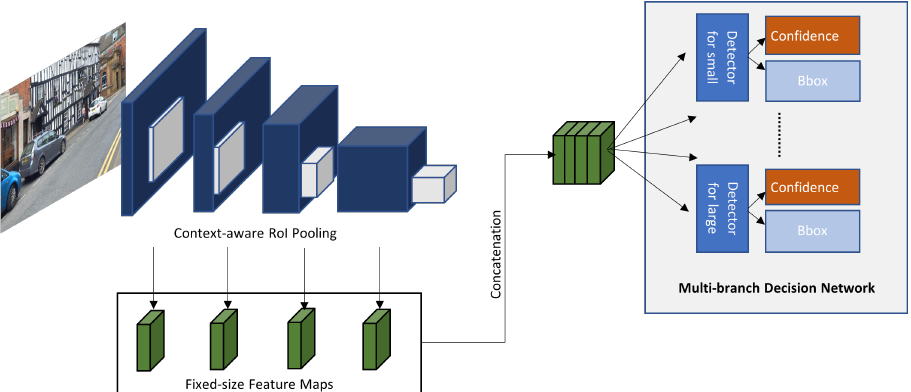
Figure 15. SInet: The blue and grey blocks are the feature maps and the proposed RoI, respectively, at different scales. The separated green blocks are the fixed size feature map, pooled by the context- aware RoI pooling for each RoI scale. The fixed size feature maps are then concatenated and used by the multi-branch decision network to classify the objects